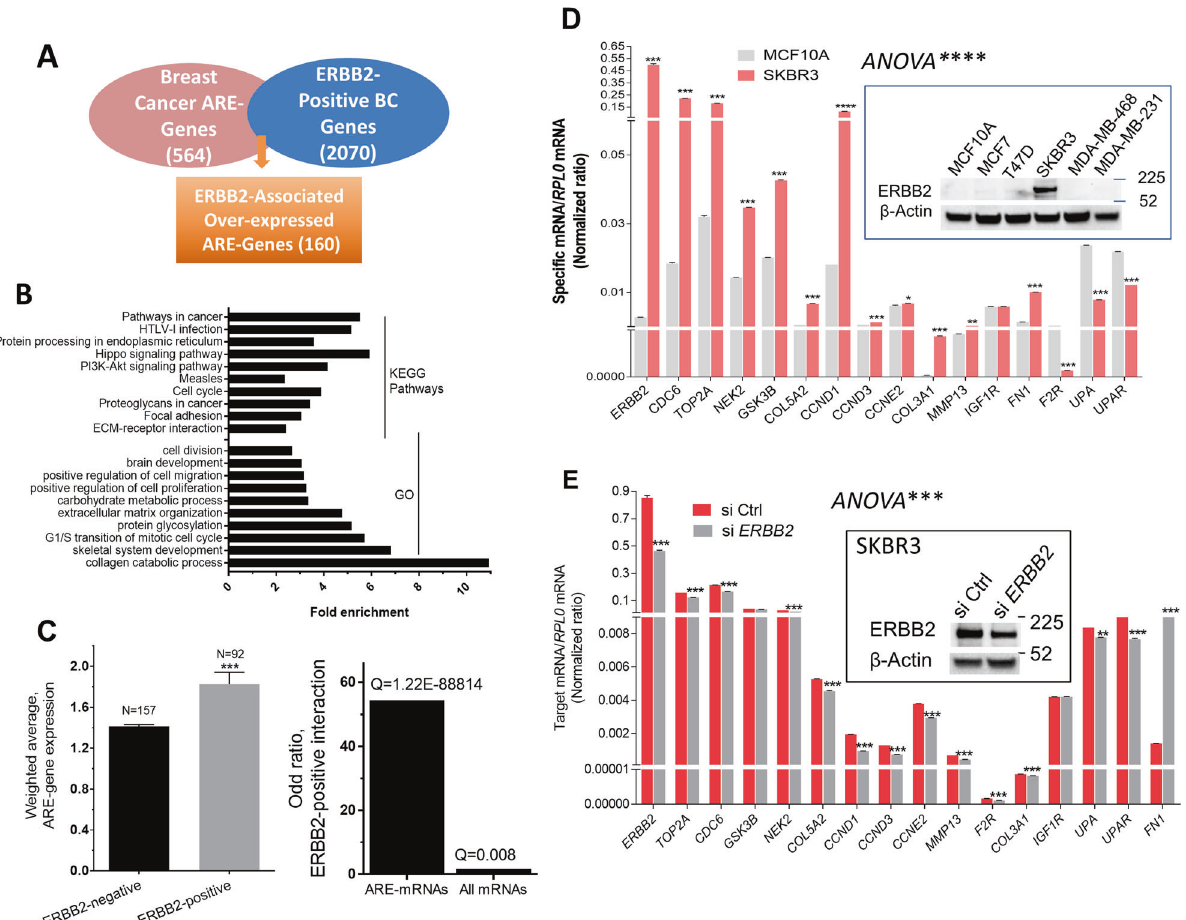
Fig. 2 Systematic analysis of ERBB2-associated ARE-coding genes in breast cancer. A The ERBB2-ampli fi cation associated expressed genes ( ≥ 1.7 fold, Q value <0.00005) were intersected with the AU-rich element database (ARED-Plus). B Functional enrichment of the ERBB2- associated ARE-coding genes. The most signi fi cant results with false discovery rate (FDR) P < 0.05 are shown. C Left panel: the mean of mRNA abundance for 160 ARE-coding genes (Fig. 1A data) was compared between TCGA ERBB2-negative and ERBB2-positive patients ’ tissue samples. Data are Mean ± SEM. *** p < 0.001 using Student ’ s t-test with Welch ’ s correction. Right panel: the interaction between the ARE-mRNA cluster or all mRNAs with ERBB2-positive gene expression data is represented by an odd ratio using Fisher ’ s exact test (Oncomine software). D Total RNA from the ERBB2-positive SKBR3 cell line and MCF10A normal-like ERBB2-negative cell lines were extracted and subjected to RT- QPCR using speci fi c primers to the indicated genes. Inset shows an immunoblot of two for the ERBB2 protein among different types of breast cancer cell lines. E The SKBR3 cells were transfected with 200 nM control siRNA or ERBB2 siRNA for 24 h, followed by RNA extraction and RT- QPCR as indicated. Inset is a representative immunoblot of three, for the ERBB2 protein. The data in D and E are normalized to the housekeeping gene, RPL0. Data are Mean ± SEM (triplicate) from one representative experiment of at least two. ANOVA test demonstrates overall statistical signi fi cance. The student ’ s t-test was used to compare expression data for each